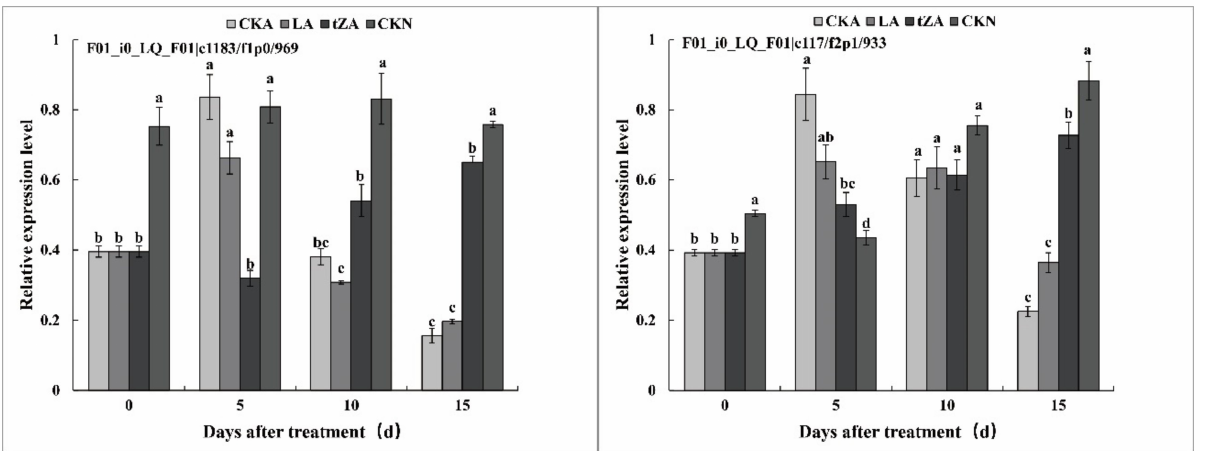
Figure 8. The relative expression level of SOD related genes in CKN, CKA, tZA and LA groups after the treatment. Different lower-case letters among different treatment groups indicate significant differences based on one-way analysis of variance in SPSS 21.0 followed by the Duncan’s test ( p <